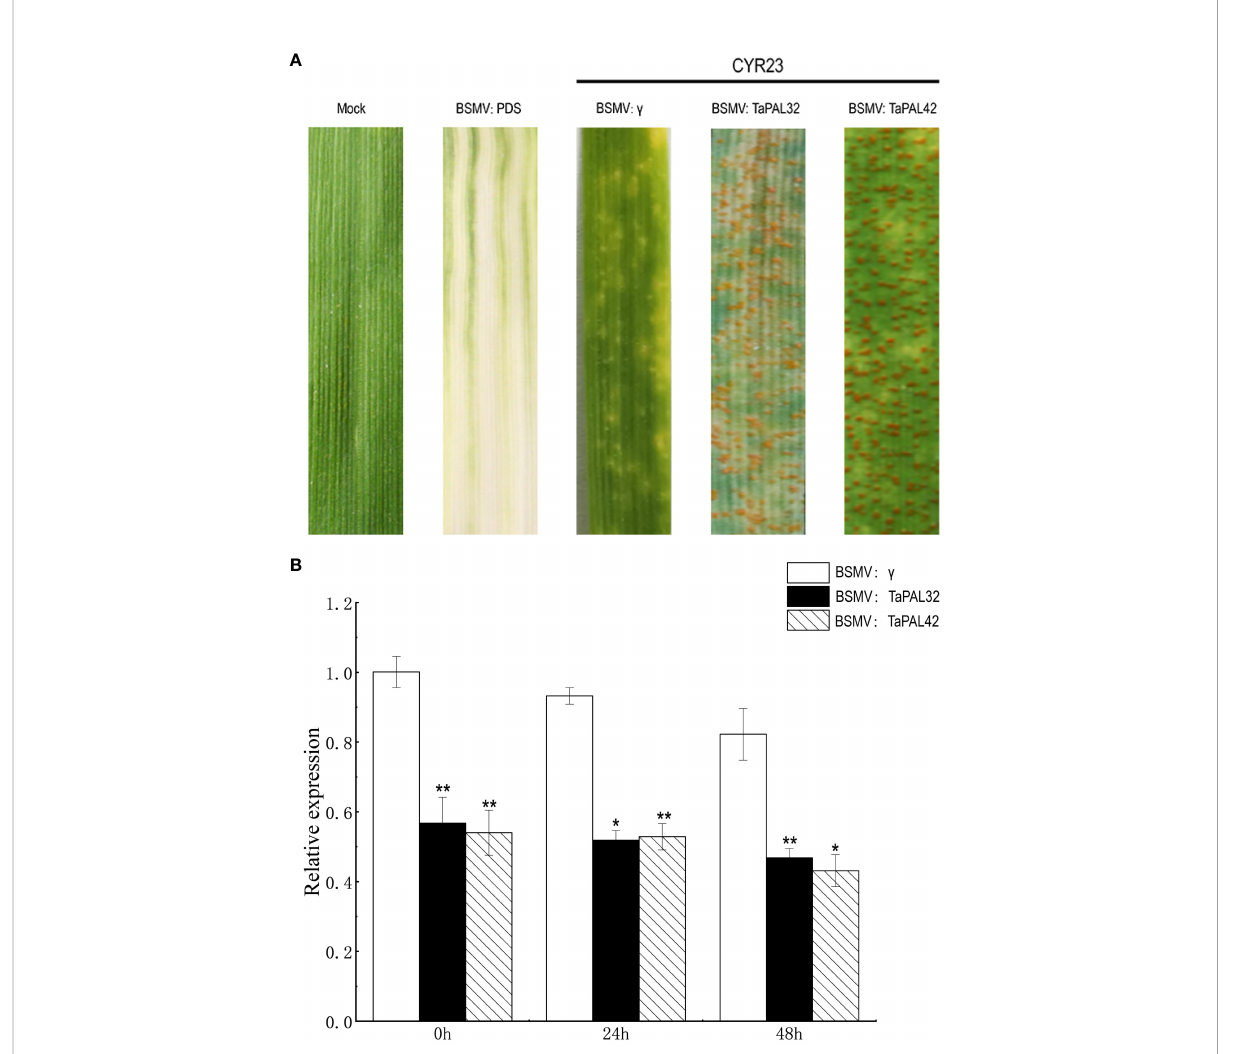
FIGURE 9 Silencing of TaPAL32 and TaPAL42 reduce the resistance of wheat to P. striiformis . (A) BSMV: TaPDS showed photobleaching at 10 dpi; Mock: wheat leaves treated with 1× Fes buffer. Disease symptoms on the leaves challenged with Puccinia striiformis f. sp. tritici race CYR23. Disease symptoms were photographed at 14 days post inoculation. (B) Silencing ef fi ciency assessment of TaPAL32 and TaPAL42 in the 0, 24, and 48 h. TaPAL32 and TaPAL42 silenced plants treated with P. striiformis (*p < 0.05, **p <